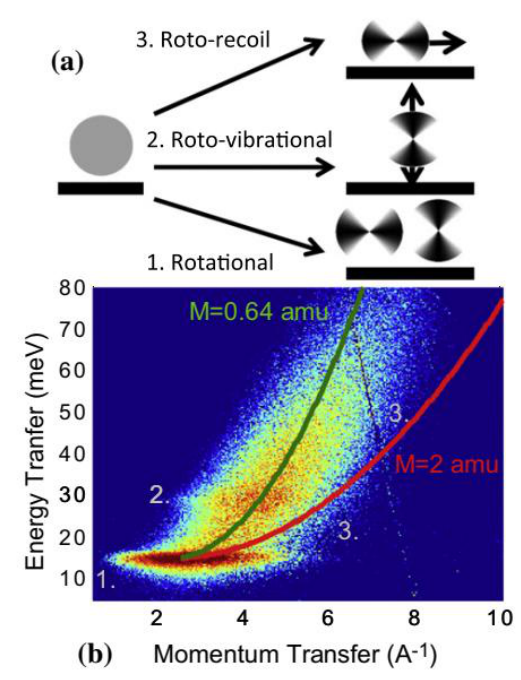
Figure 4. ( a ) Schematic representation of various molecular motions of H 2 in a nanotube, as conven- tionally expected. ( b ) Experimental INS results from H 2 in C-nanotubes. Incident neutron energy: E 0 = 90 meV; [24]. The translation motion of H 2 molecules is attributed to the observed continuum of intensity, also termed “roto-recoil” (yellow-orange ribbon). The K − E position of the first rotational excitation of H 2 (dark red-brown ellipsoid) is in accord with conventional theory. In contrast, a blatant disagreement with conventional theory holds for the roto-recoil data: A fit (green parabola) to this yields the effective mass M ef f ≈ 0.64 a.m.u. for the translating H 2 molecule. The red parabola on the right shows the conventionally expected recoil parabola for the H 2 -mass which is M = 2 a.m.u. (Reproduced from [24], with permission of Elsevier